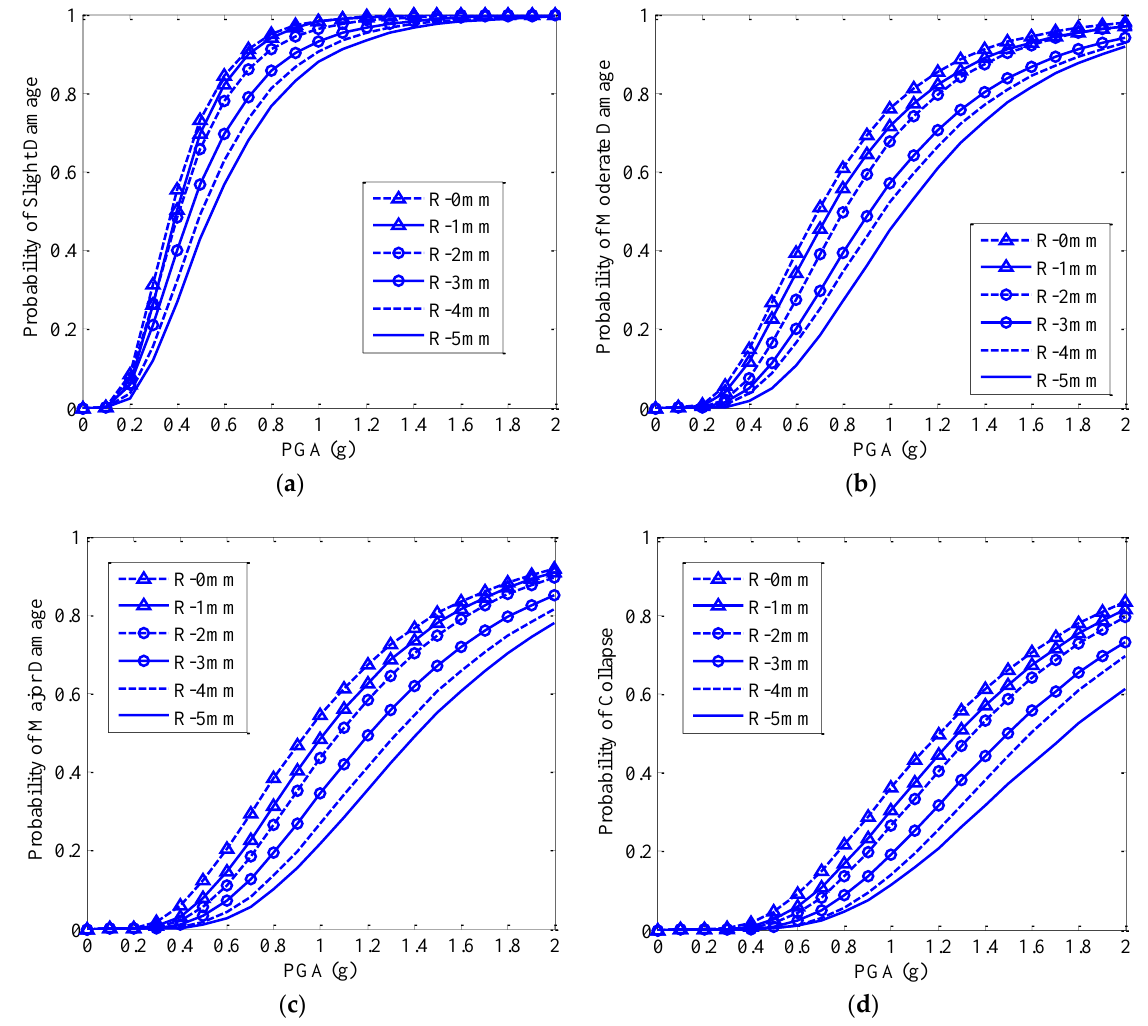
Figure 6. Fragile curves of the bridge system with 20% pitting corrosion strengthened by steel plates. ( a ) Slight damage, ( b ) moderate damage, ( c ) major damage, ( d ) collapse.